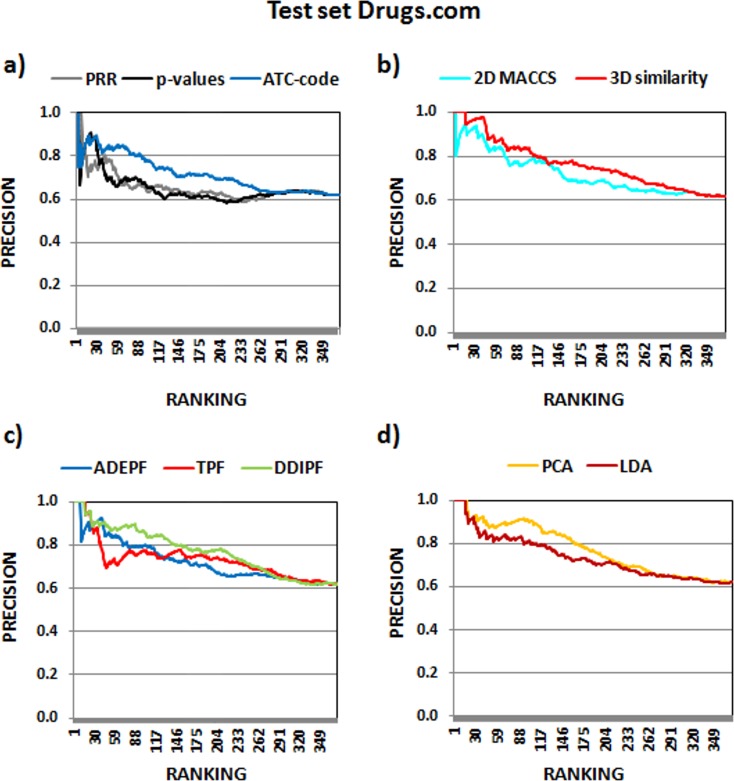
Precision of the different methods in test set 4 with all the interactions described in the reference standard Drugs.com (high and moderate clinically significant interactions).